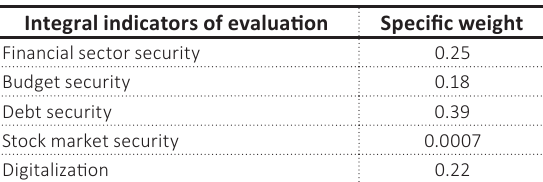
Table 2. Specific weight of integral indicators for evaluating financial sector security, stock market security, debt and budget security, and